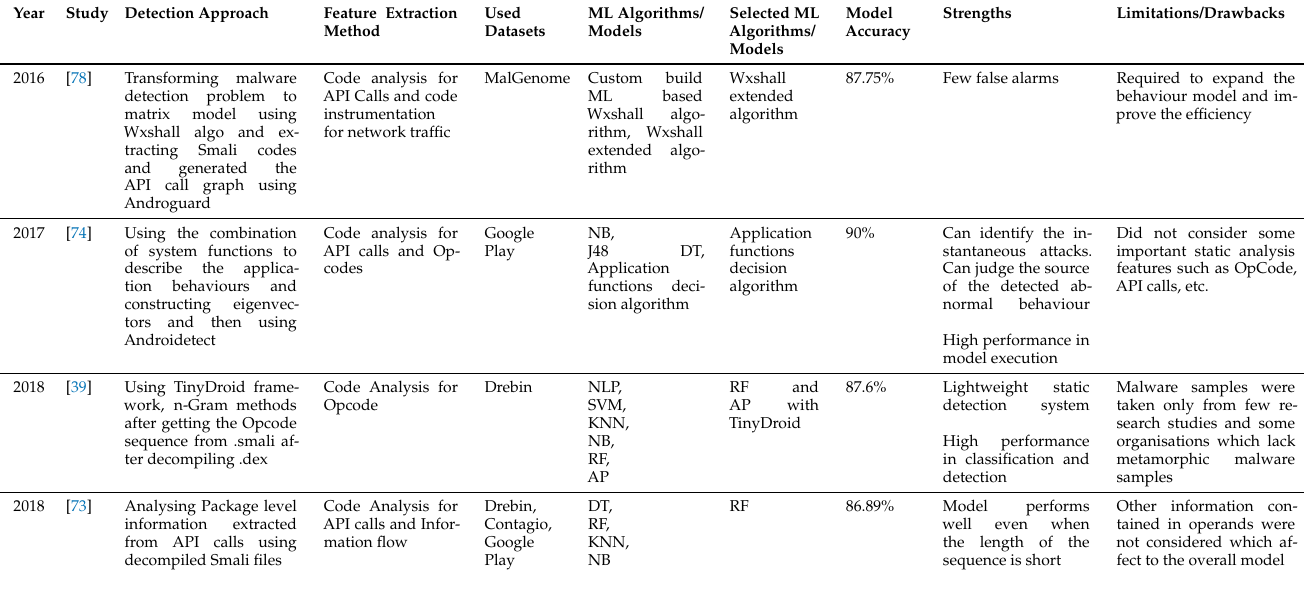
Table 2. Code based static Analysis with ML (Model Accuracy is below 90%).